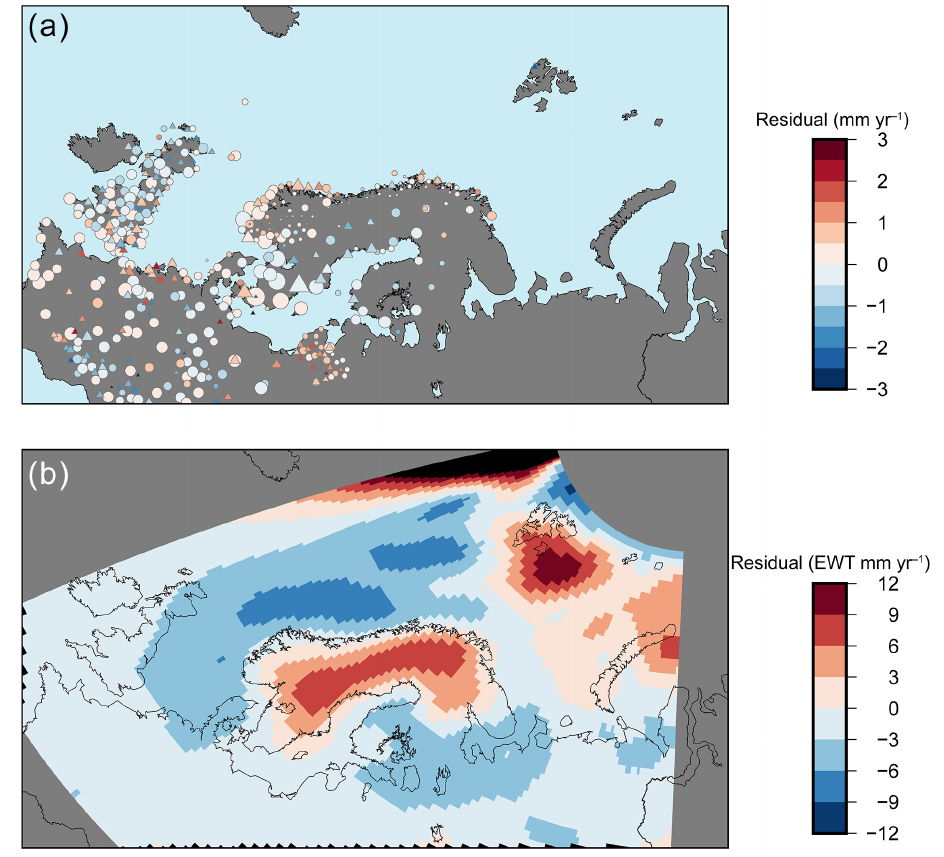
Figure 8. Spatial residuals for the D3 model for vertical motion (a) and gravity change (b) . In (a) , triangles indicate that model prediction is outside the 1 σ uncertainty of the measurement; circles indicate that model prediction is inside the 1 σ uncertainty of the